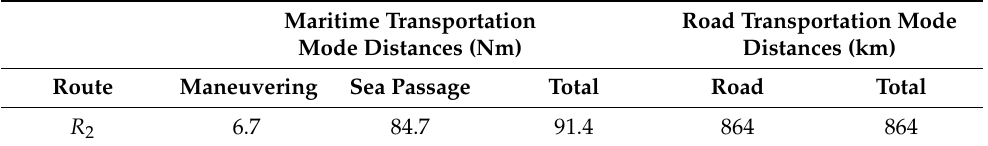
Table 11. Determined distances on route R 2